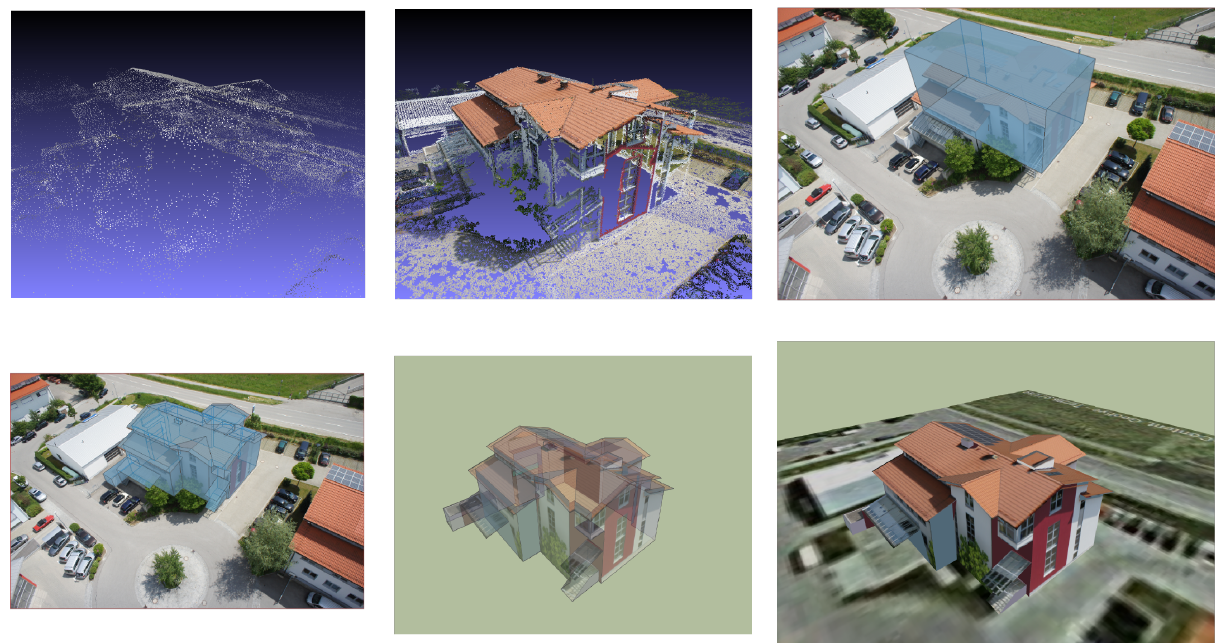
Figure 5: Side house dataset. From left to right, top to bottom: bundle block 3D points, dense matching colorized 3D points, box model on top of registered image, untextured 3D refined model on top of registered image, textured refined 3D model with translucide faces, geolocalized textured refined 3D